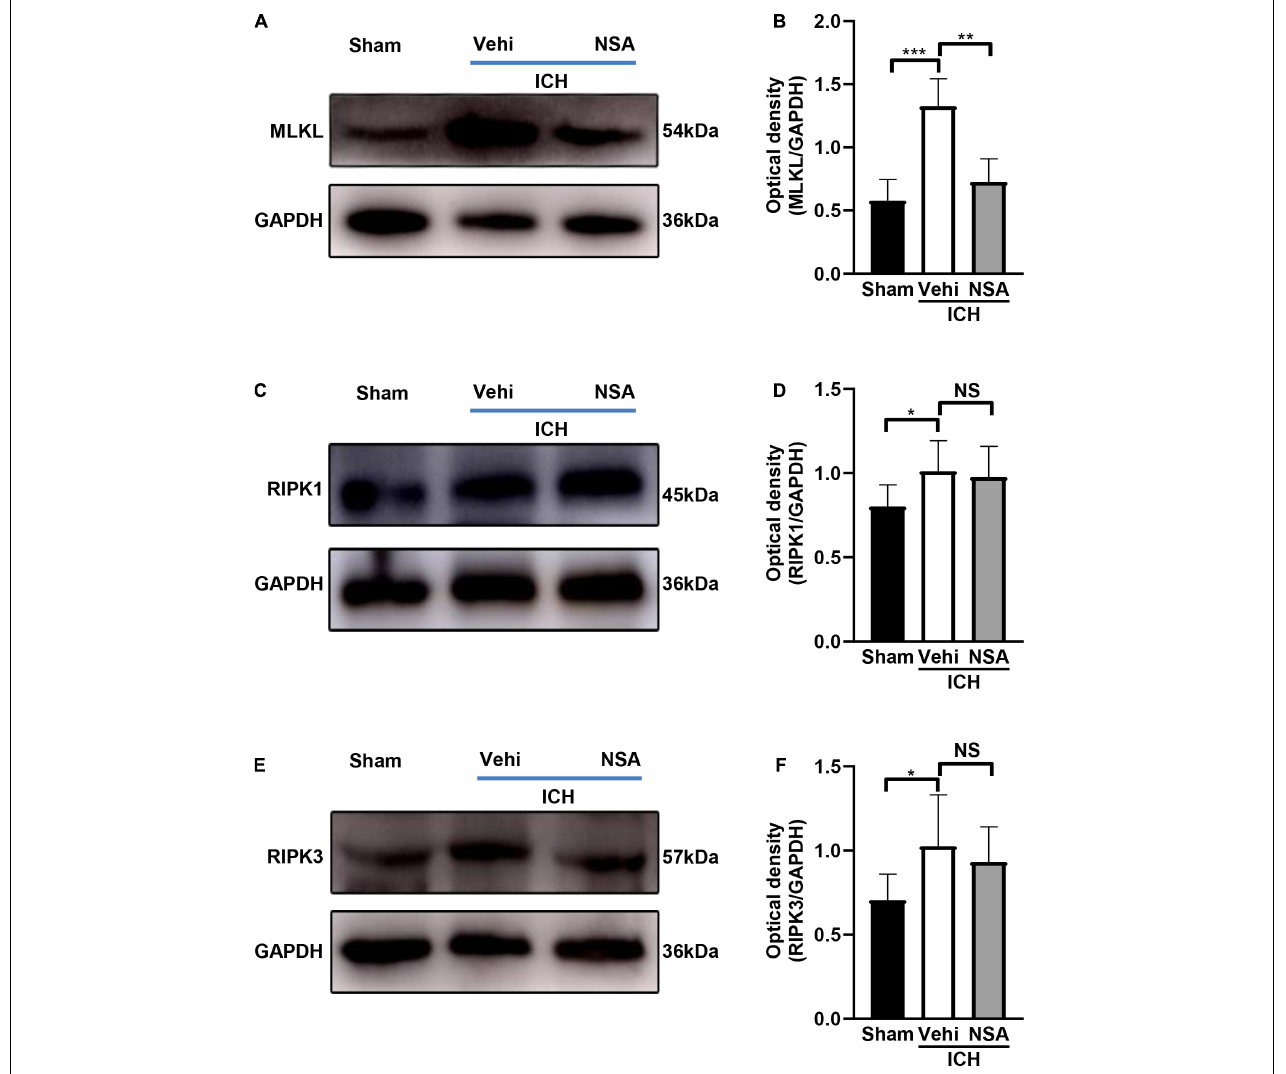
FIGURE 3 | The effects of necrosulfonamide (NSA) on the expression of MLKL, RIPK1, and RIPK3 at 3 days after intracerebral hemorrhage (ICH). (A,C,E) Representative western blotting images of the expression of MLKL, RIPK1, and RIPK3, respectively. (B,D,F) Quantification shows that NSA reduced the expression of MLKL ( n = 3, per group), but not of RIPK1 ( n = 3, per group) or RIPK3 ( n = 3, per group) after ICH. Data are shown as mean ± SD, * p < 0.05, ** p < 0.01, *** p < 0.001.